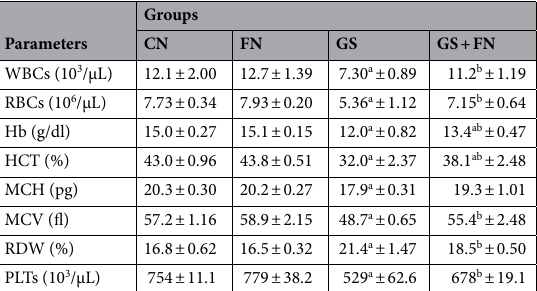
Table 2. Hematological parameters in the investigated groups. Data are presented as means ± SD. CN control, FN Fenugreek diet, GS gasoline. a,b Superscripts refer to significant changes ( p < 0.05). a All groups compared to the CN group. b GS + FN group compared to the GS group.